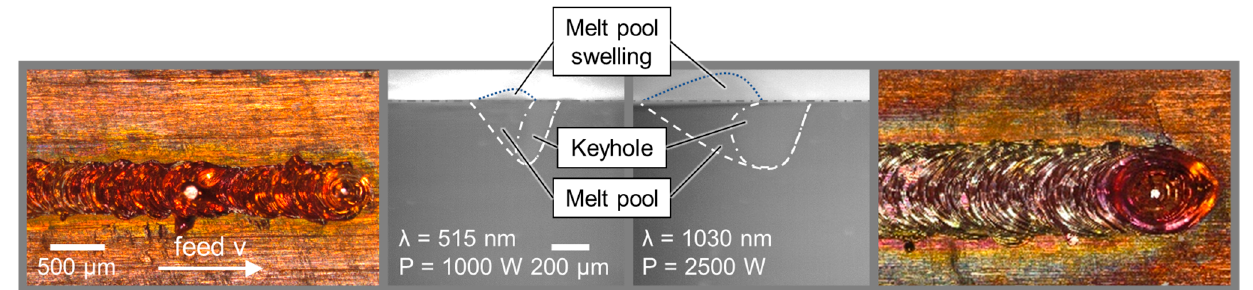
Figure 11. Compilation of X-ray video sequences and corresponding top views of the weld seams during laser beam welding of copper using 515 nm ( left ) and 1030 nm ( right ) laser radiation at a keyhole depth of e ≈ 0.4 mm, v = 200 mm/s; further parameters see insert.